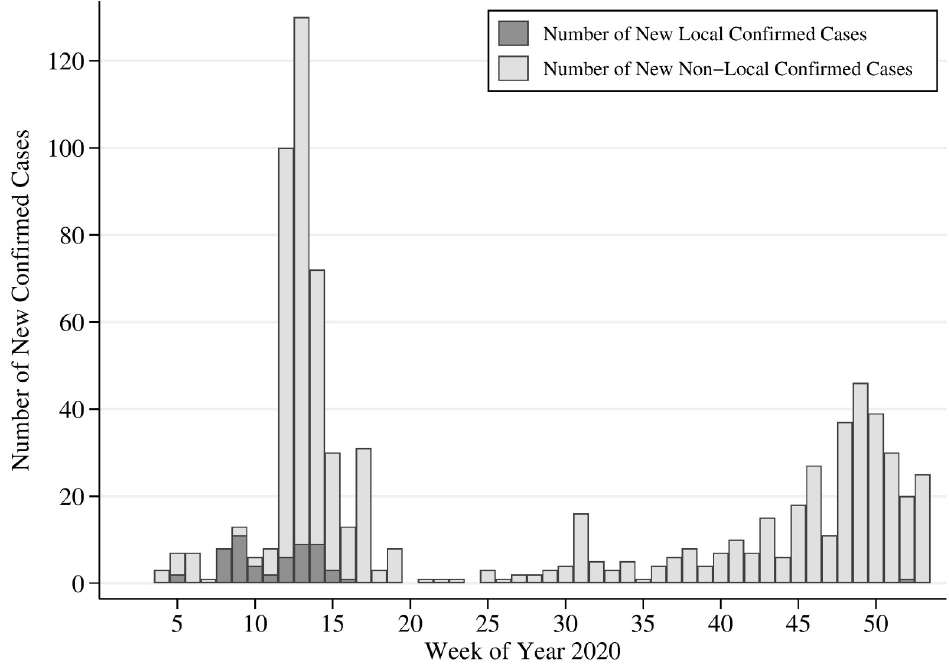
Fig 1. Weekly number of newly confirmed COVID-19 cases in Taiwan. This figure displays weekly numbers of newly confirmed COVID-19 cases in Taiwan. The dark color represents the number of new local confirmed cases in a given week, and the gray color means weekly numbers of new imported cases. Data source comes from